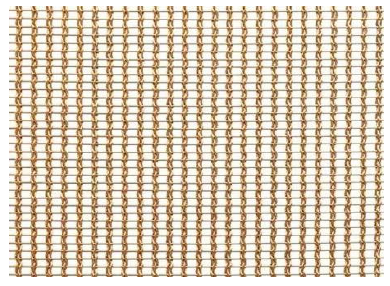
Figure 4. Copper wire mesh.